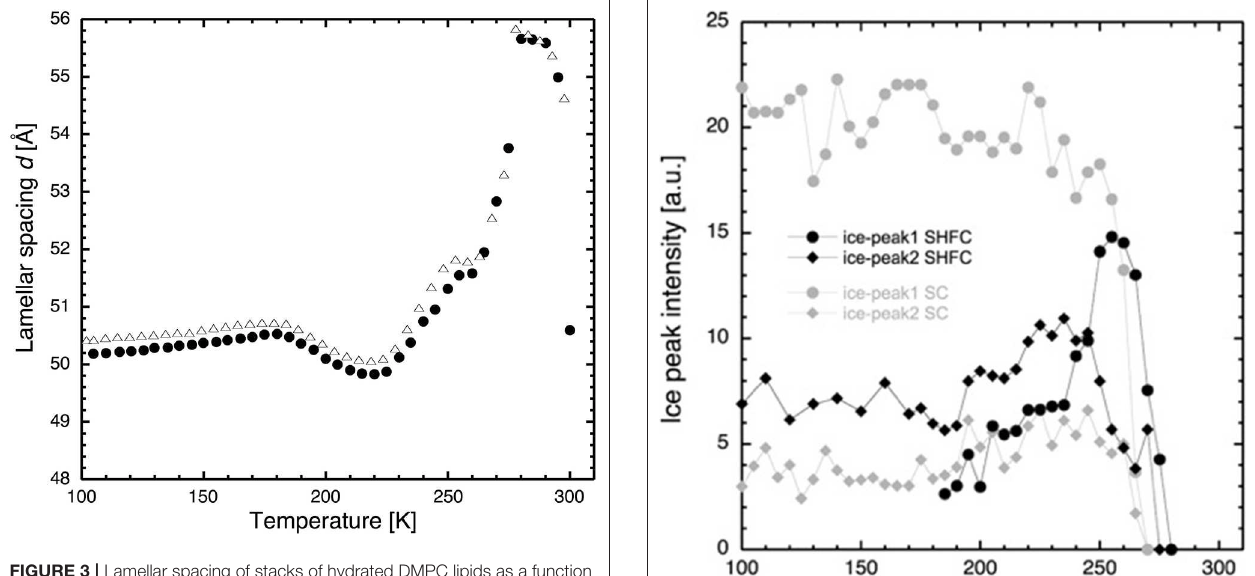
FIGURE 3 | Lamellar spacing of stacks of hydrated DMPC lipids as a function of temperature as determined by neutron diffraction on D16 after flash cooling upon heating from 100 to 300K (SHFC protocol). Closed circles correspond to the data presented in Figure 2 , open triangles to those resulting from a repeated experiment carried out with the same sample. The similarity of the two curve profiles informs about the reproducibility of the experiment.